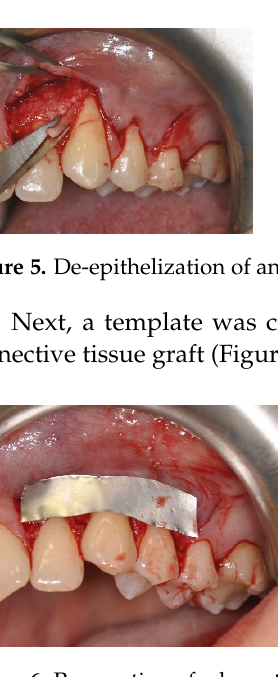
Figure 4. Trapezoidal flap after vertical releasing incisions.